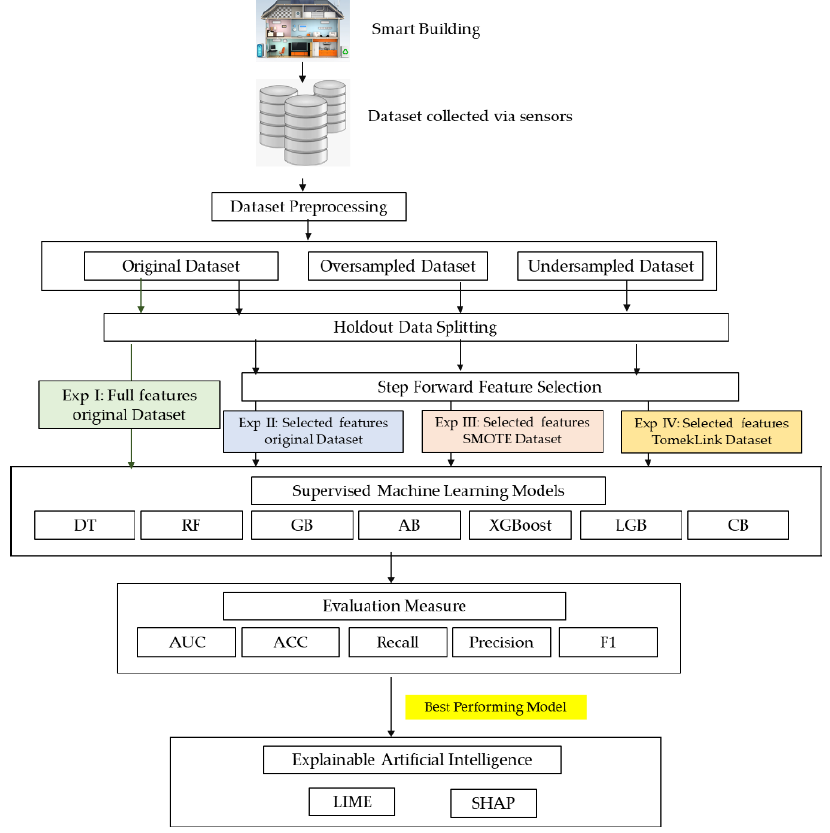
Figure 1. Proposed methodology framework.